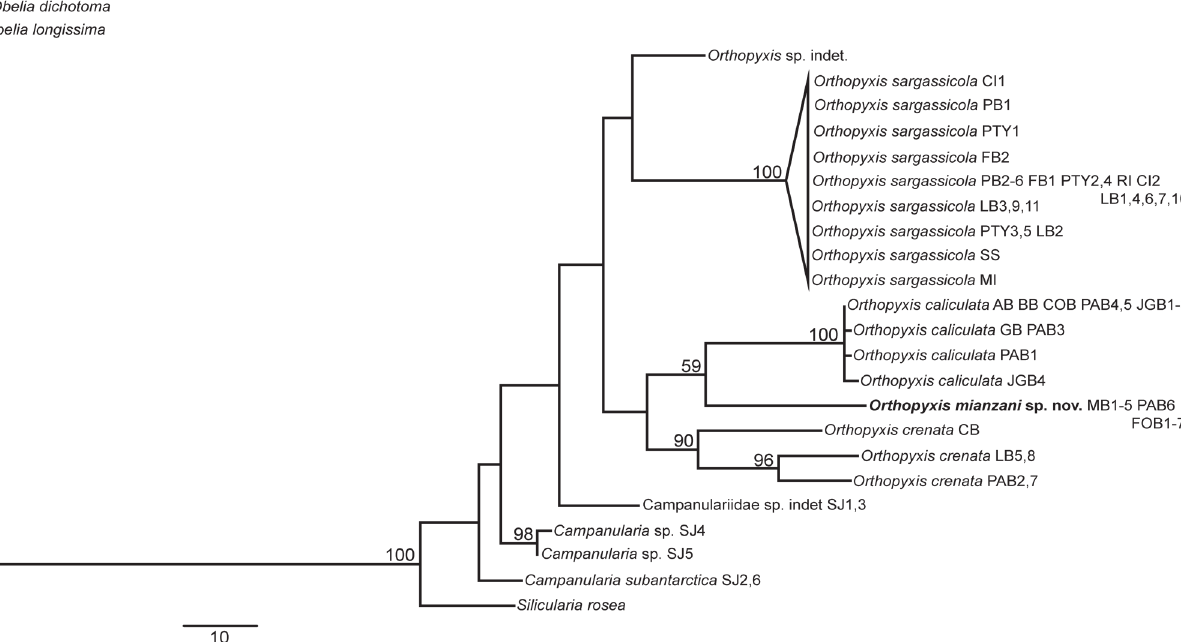
Fig 5. One of the three most parsimonious trees based on 16S data. These trees are only different in the position of the haplotypes within O. sargassicola clade, which is collapsed. Bootstrap values are shown for each node. Nodes without numbers indicate support below